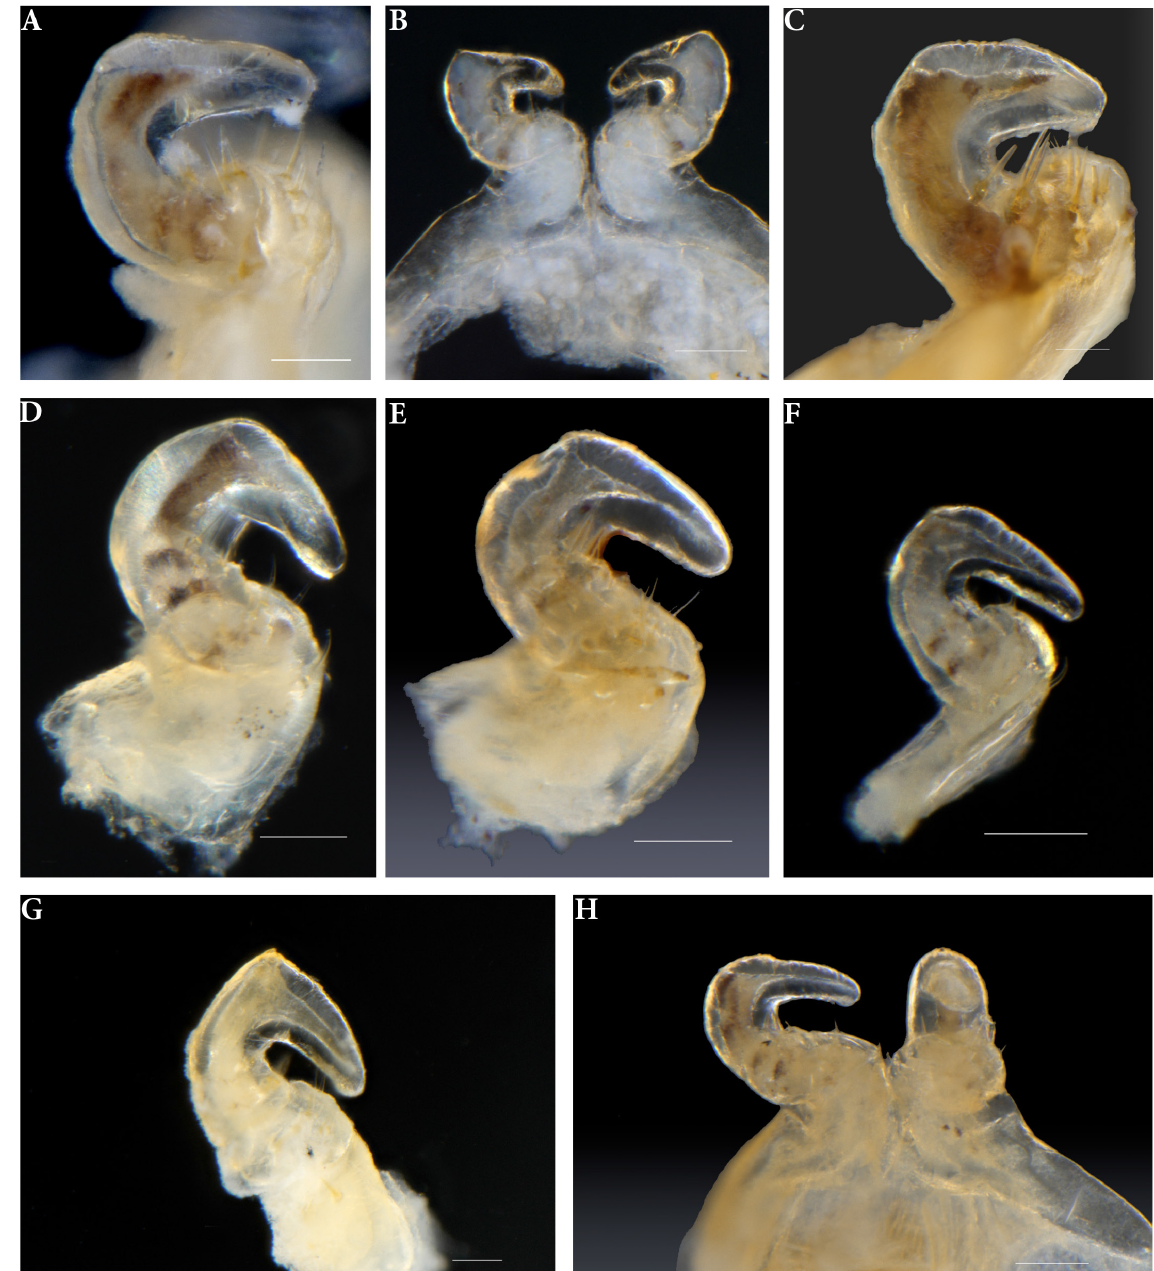
Fig. 25. First leg pair. A . Ommatoiulus alacygni sp. nov. B . O. andalusius (Attems, 1927). C . O.